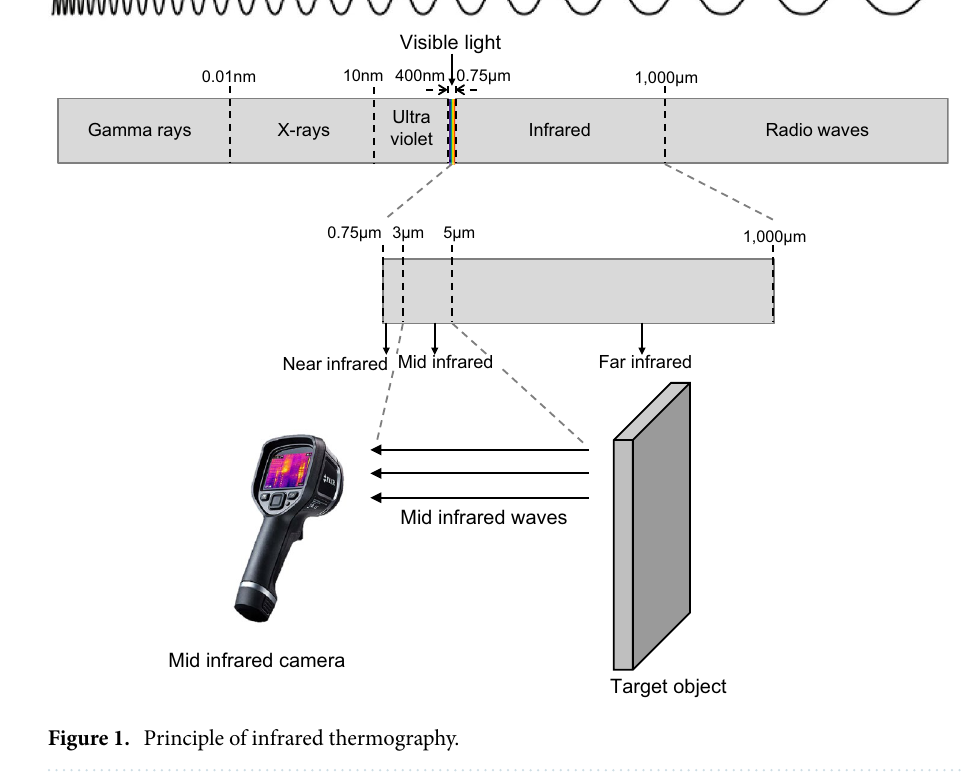
Figure 1. Principle of infrared thermography.